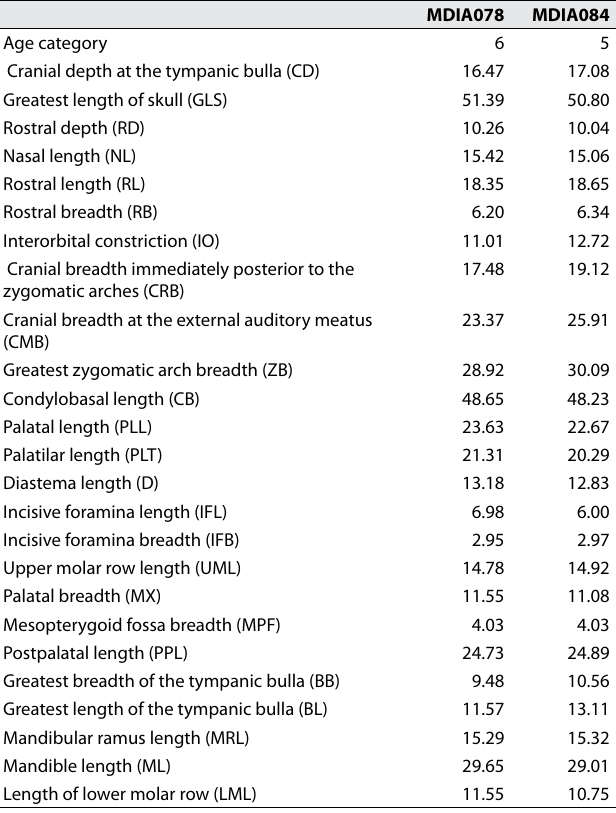
Table 1 . Selected measurements (in mm) of the two specimens of Euryzy- gomatomys spinosus from Sempre Vivas National Park, Minas Gerais,